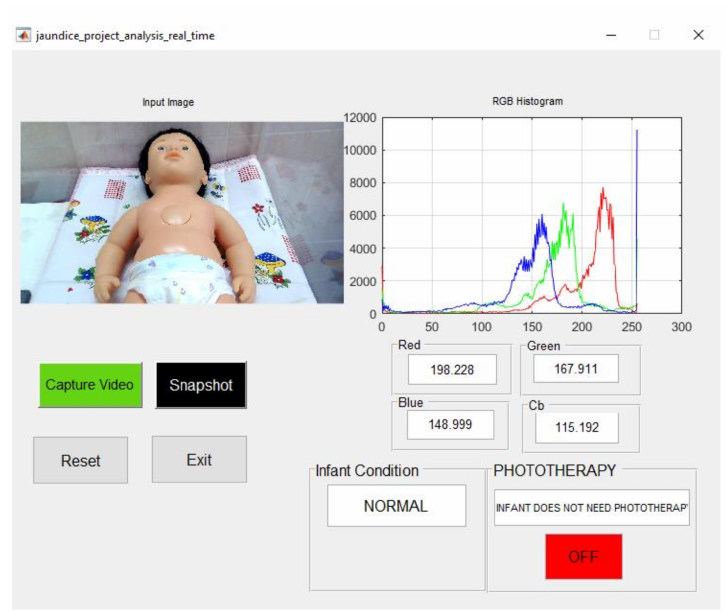
Figure 5. A manikin with light skin color (jaundice-free).